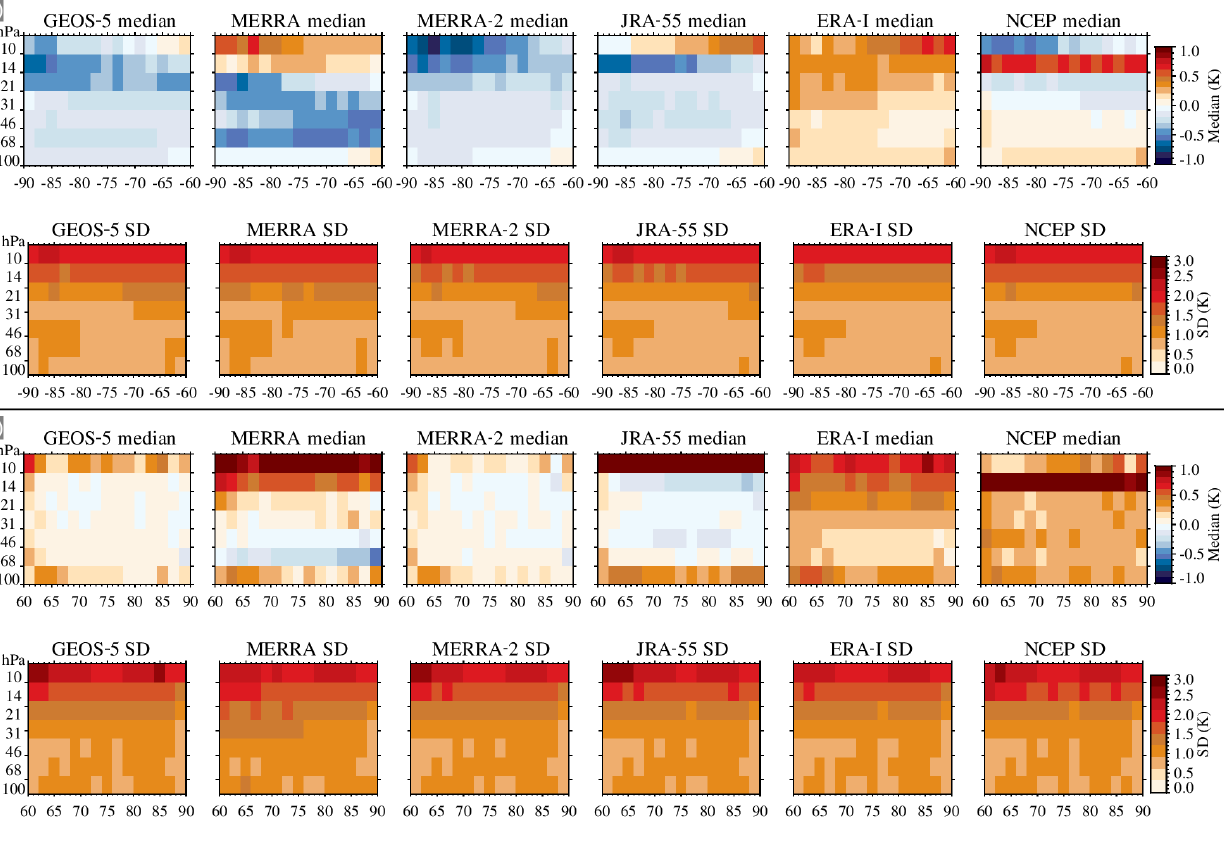
Figure 6. Zonal distributions of the median and standard deviations of the differences between the reanalysis temperatures and COSMIC temperatures ( T re − T COSMICRO ) averaged over 2008–2013 for (a) the Antarctic (90–60 ◦ S) and (b) the Arctic (60–90 ◦